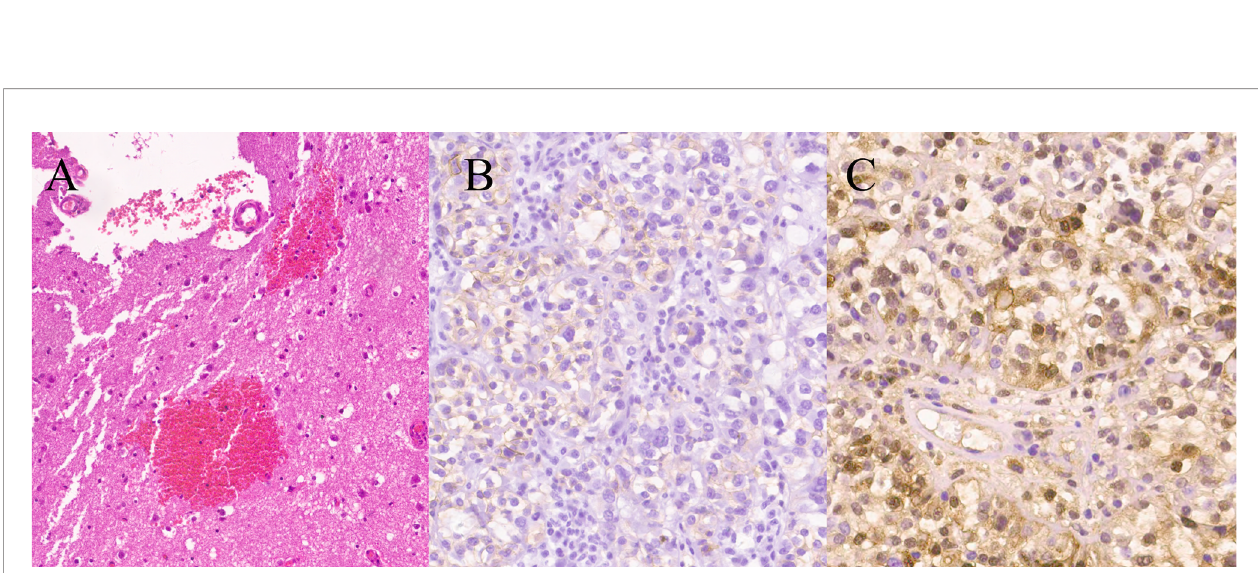
FIGURE 2 | Photomicrographs of surgical specimens. The tumor was well-encapsulated with a distinct fi brous capsule with normal choroid plexus attached (arrow). (H&E stain, ×10) (A) . Immunohistochemical staining for CD 99 and S100-beta were positive (×200) (B, C) .